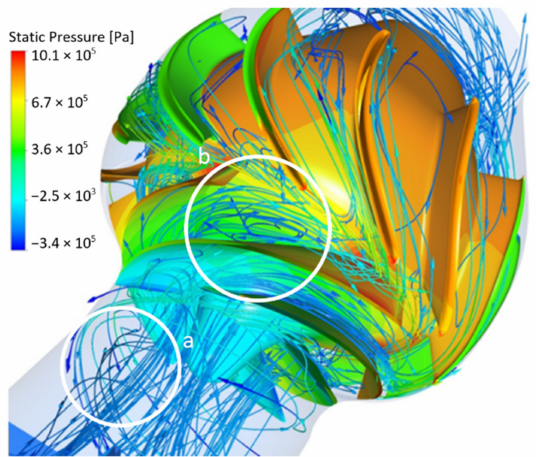
Figure 10. Suction recirculation at 30% of QBEP. The pump operating at this reduced flow causes the flow to separate from the blade and circulate back upstream, and in this case, even back to the suction pipe. Undesirable phenomena such as eddies and pre-rotation are observed to form